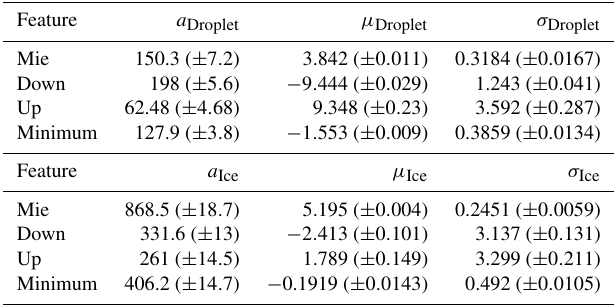
Table A1. Fit parameters of the Gaussian fits for the distribution of the feature parameters n i .